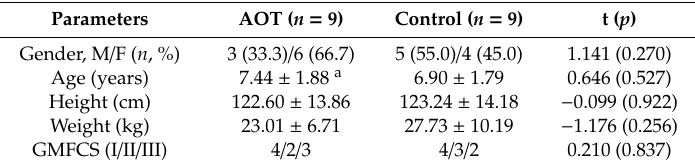
Table 2. General characteristics of subjects ( N =